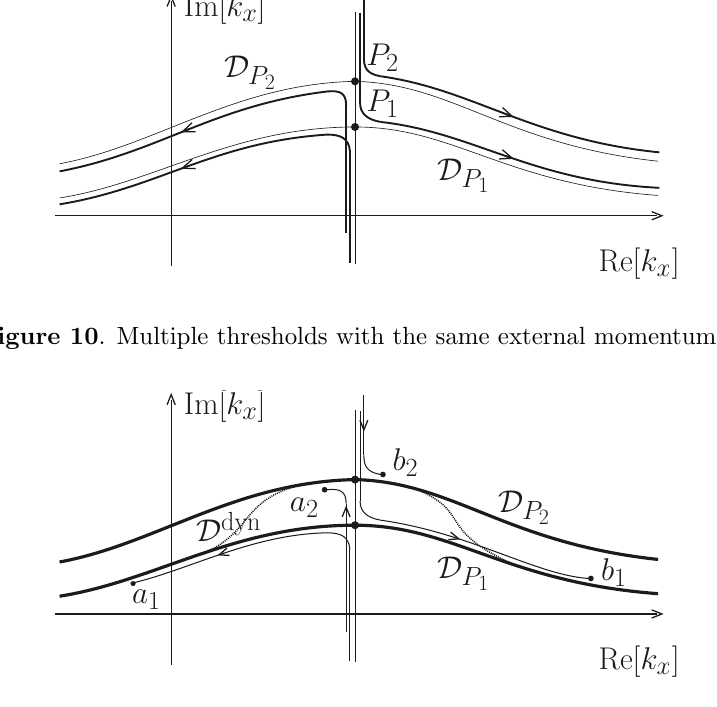
Figure 11 . \Animation" of trajectories in the k x complex plane in the presence of multiple thresholds with the same external momentum p